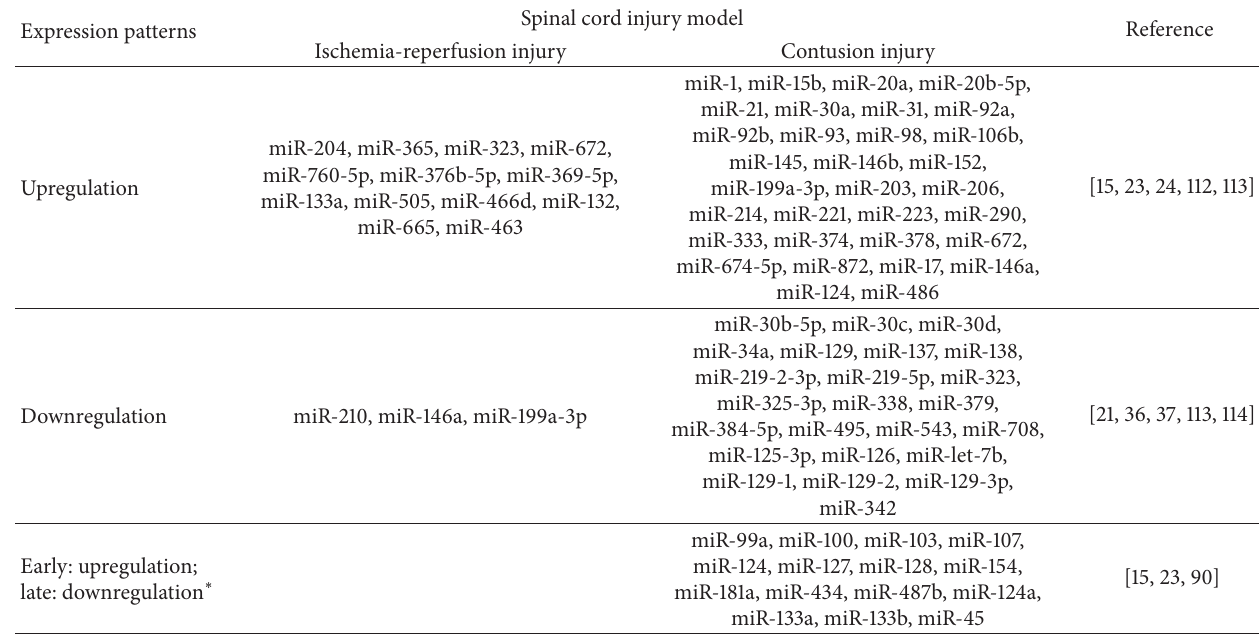
Table 1: Differentiated expression of microRNAs in different spinal cord injury